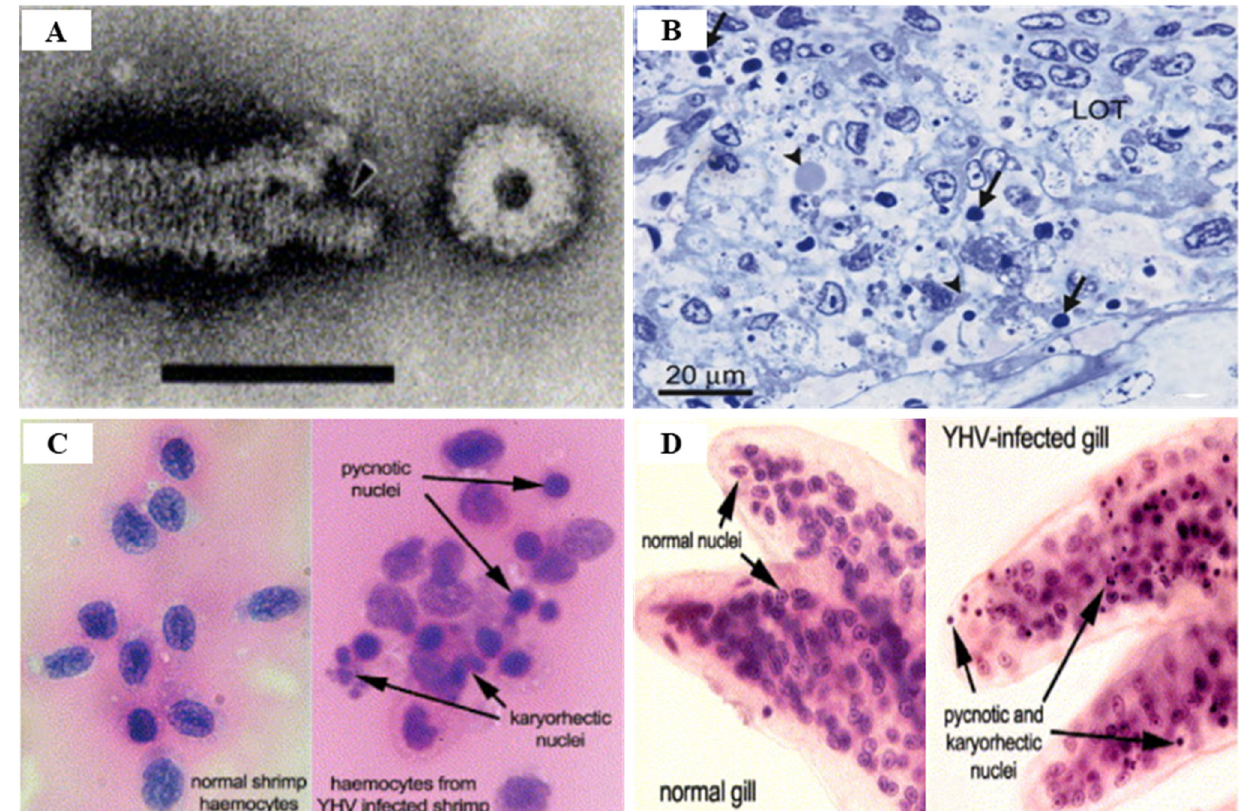
Figure 17. Electron microscopy and histological changes in shrimp infected with yellow head virus genotype 1 (YHV). ( A ) TEM of negative-strained YHV virions (Scale bars = 100 nm); ( B ) LO tissue of moribund shrimp from YHV immersion challenged P. vannamei at day 5 showing numerous pyknotic nuclei (arrows), karyorrhectic nucleic and cytoplasmic inclusion (arrow heads); ( C ) Hemolymph from normal and YHV infected shrimp identified by staining hemolymph smears; ( D ) Gills of YHV infected shrimp stained with H&E in rapidly fixed and stained (3 h) whole mounts. (( A ) Reprinted from Advances in virus research, Vol. 63, Dhar, A.K., Cowley, J.A., Hasson, K.W., Walker, P.J., Genomic organization, biology, and diagnosis of Taura syndrome virus and yellow head virus of penaeid shrimp, p. 69, Copyright (2004), with permission from Elsevier; ( B ) Reprinted from Developmental & Comparative Immunology, Vol. 32 (6), Anantasomboon, G., Poonkhum, R., Sittidilokratna, N., Flegel, T.W., Withyachumnarnkul, B., Low viral loads and lymphoid organ spheroids are associated with yellow head virus (YHV) tolerance in whiteleg shrimp Penaeus vannamei , p. 14, Copyright (2008), with permission from Elsevier; ( C , D ) Reprinted from Aquaculture, Vol. 258 (1–4), Flegel, T.W., Detection of major penaeid shrimp viruses in Asia, a historical perspective with emphasis on Thailand, p.